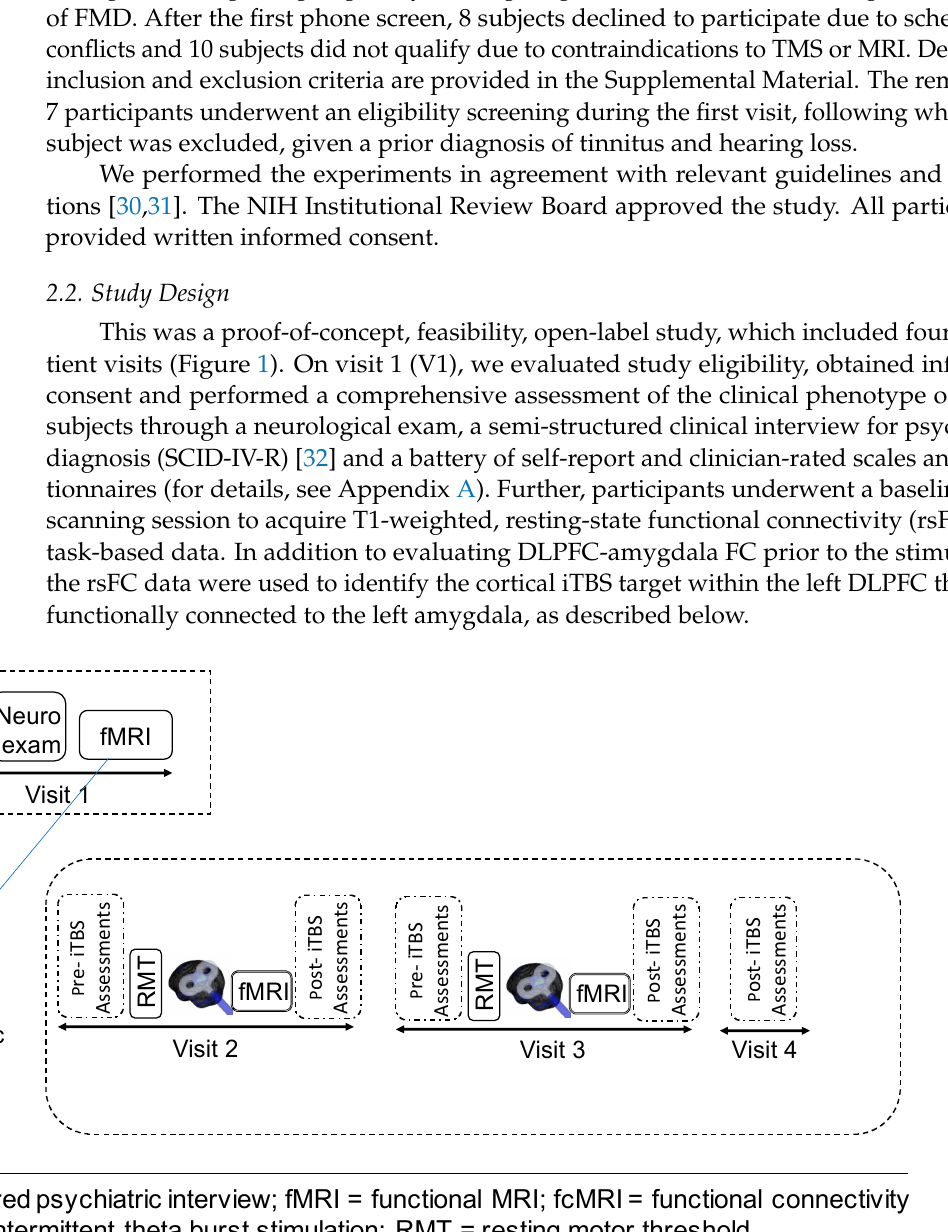
Figure 1. Schematic representation of the study